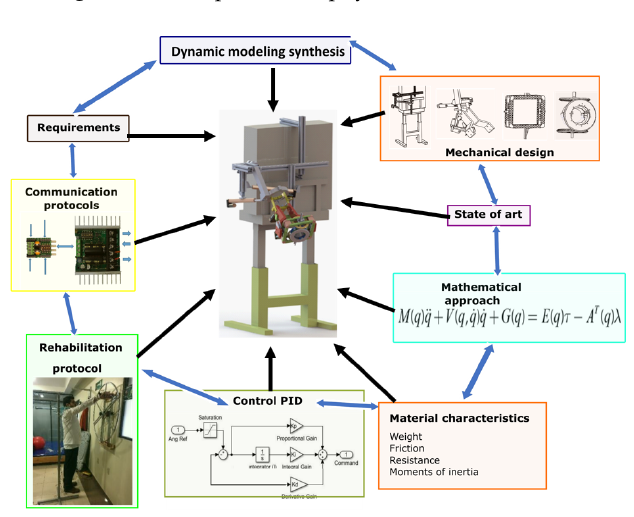
Figure 8. Simulation of the ERMIS using a digital